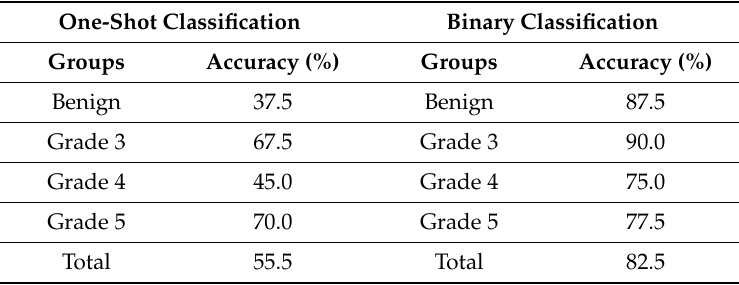
Table 8. Multilayer perception (MLP) classifier, comparison between one-shot and binary